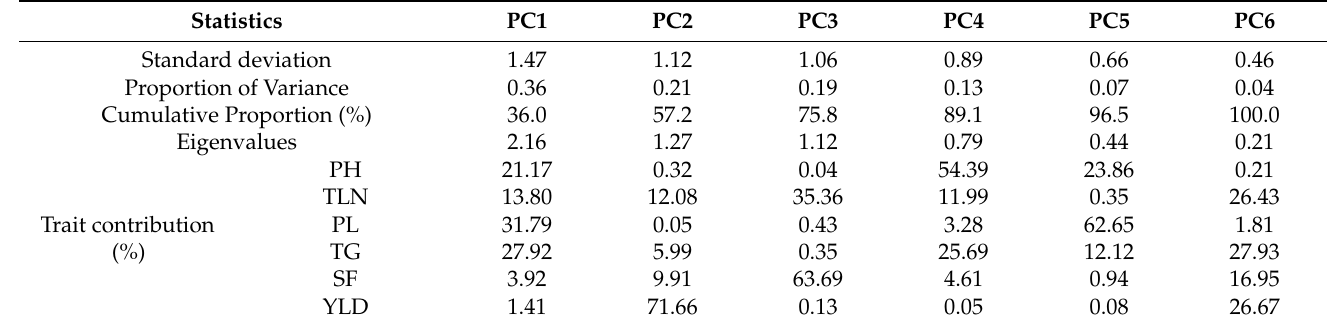
Table 2. Statistics of the principal components obtained from the agro-morphological traits among the tropical japonica lines. The contribution of different traits to major principal components is given in